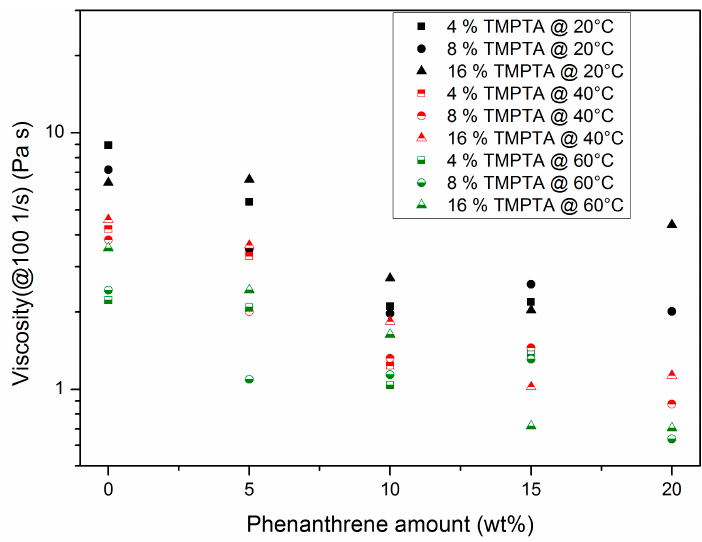
Figure 3. Influence of temperature, TMPTA, and phenanthrene content on the viscosity of the mixture at a fixed shear rate of 100 1/s.